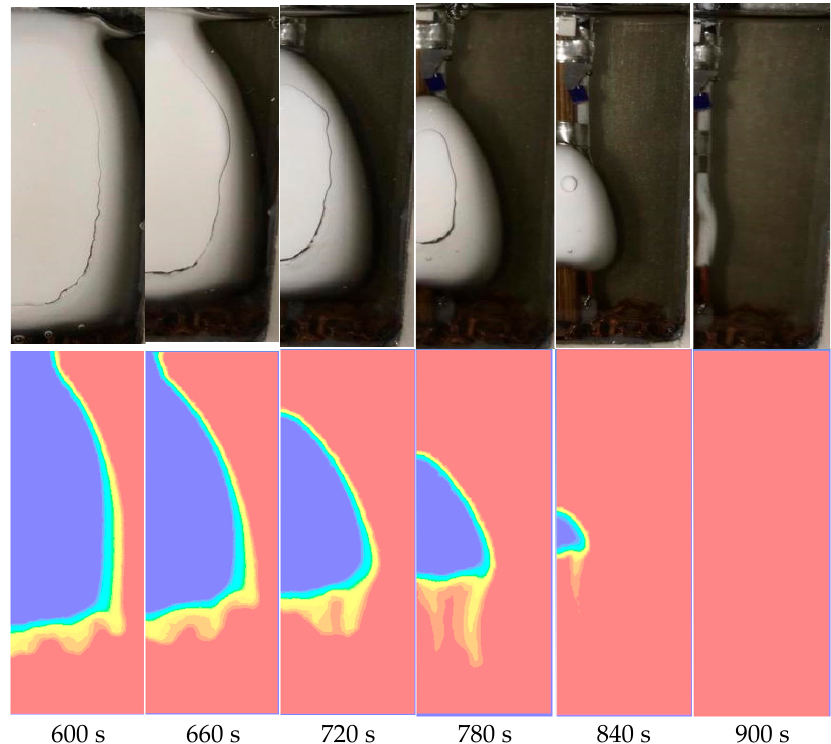
Figure 9. Experimental and simulated results of the melting pure paraffin.